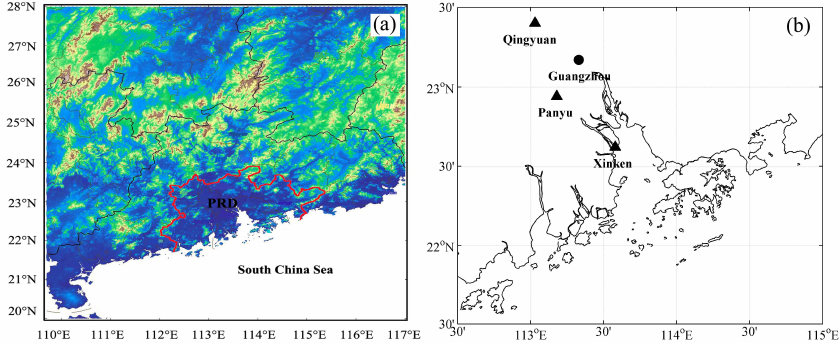
Fig. 1. Map of study area used during the PRD ABL experiment. Qingyuan, Panyu, and Xinken are the three specific sites of